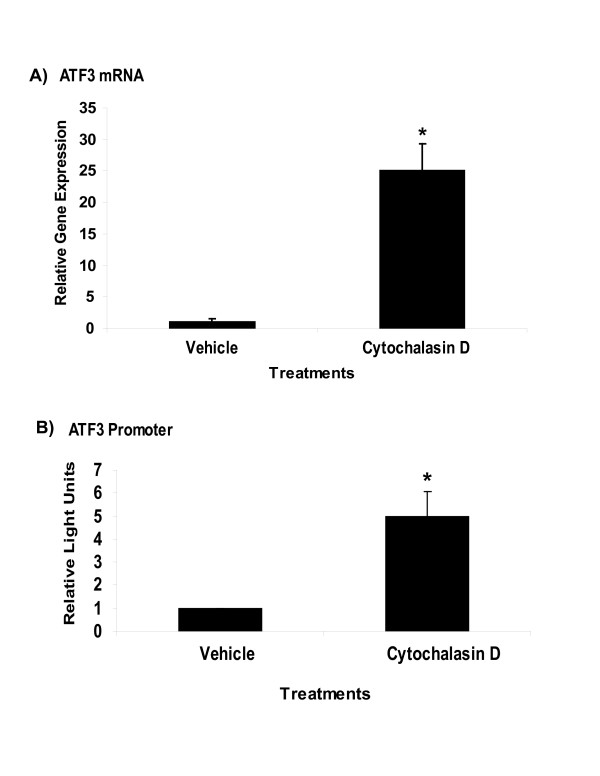
Inhibition of actin polymerization induces Atf3 expression through transcriptional mechanisms. A) Primary chondrocytes were cultured for 24 hours with DMSO (control) or 1 μM cytochalasin D before harvest and RNA isolation. Real-time PCR demonstrated marked induction of Atf3 mRNA levels by cytochalasin D. Data represent averages and SEM from three independent experiments, normalized to Gapdh (*: p < 0.05). B) Primary chondrocytes were transfected with an Atf3 promoter plasmid and pRLCMV, followed by incubation for 24 hours with DMSO (control) or 1 μM cytochalasin D. Cells were then harvested, firefly luciferase activity was measured and normalized to Renilla luciferase activity. Data represent averages and SEM from three independent experiments, performed in quadruplicate each (*: p < 0.05). Cytochalasin D induced Atf3 promoter activity.